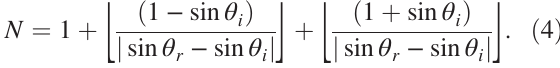
Figure 2 plots this relationship for θ θ ∈ ½ − 90 ° ; 90 ° (cid:2) . The sizable region shaded in dark blue r ( N ¼ 2 ) on the left side of the plot indicates the region for which there exists only two propagating diffraction modes.